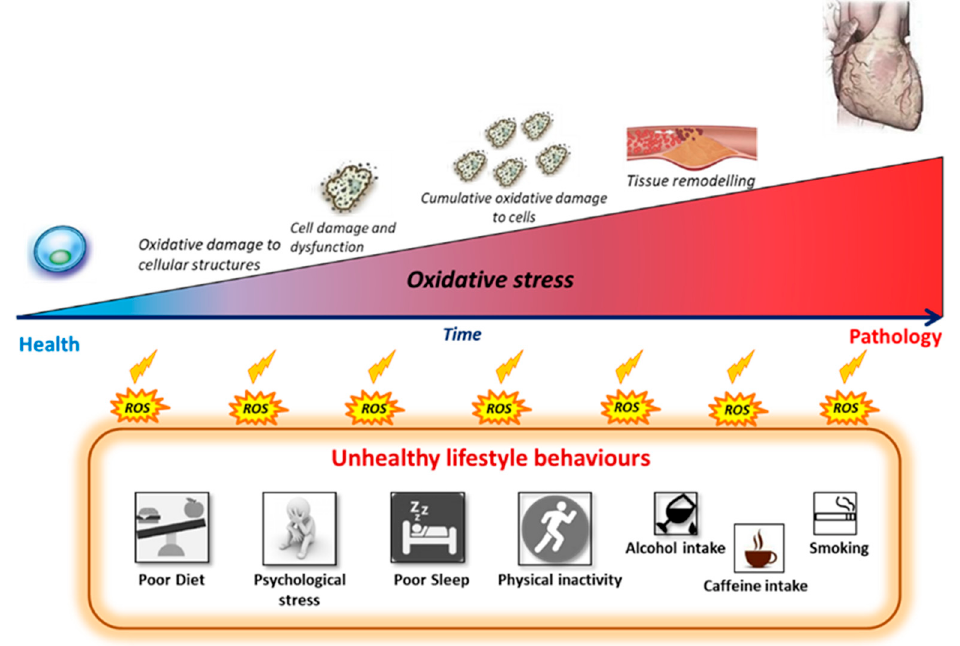
Figure 3. Progressive oxidative damage processes induced by chronic exposure to unhealthy lifestyle behaviours. Adherence to unhealthy lifestyle behaviours can gradually shift the body’s redox balance toward a state of oxidative stress with chronic subclinical damage to cells, tissues and organs. Oxidative damage plays a major role in the onset and development of non-communicable disease such as cardiovascular disease. ROS: Reactive oxygen